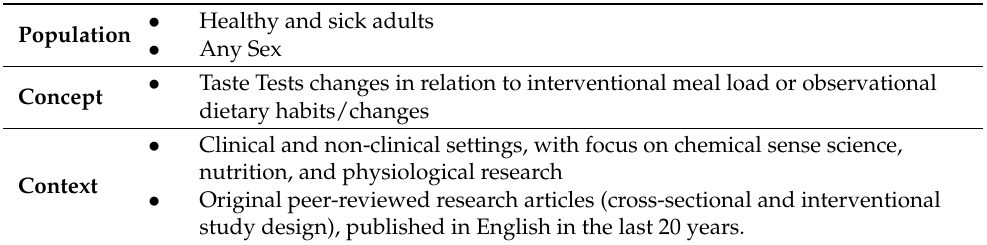
Table 1. Inclusion criteria for the scoping review summarized according to the Population–Concept– Context (PCC) mnemonic, recommended for scoping reviews